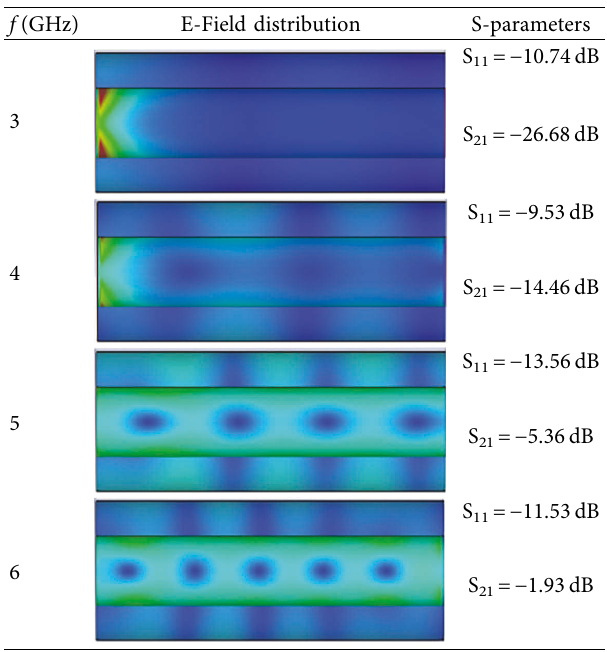
Table 2: The scattering parameters and the electric field distri- butions at the antenna mode region.